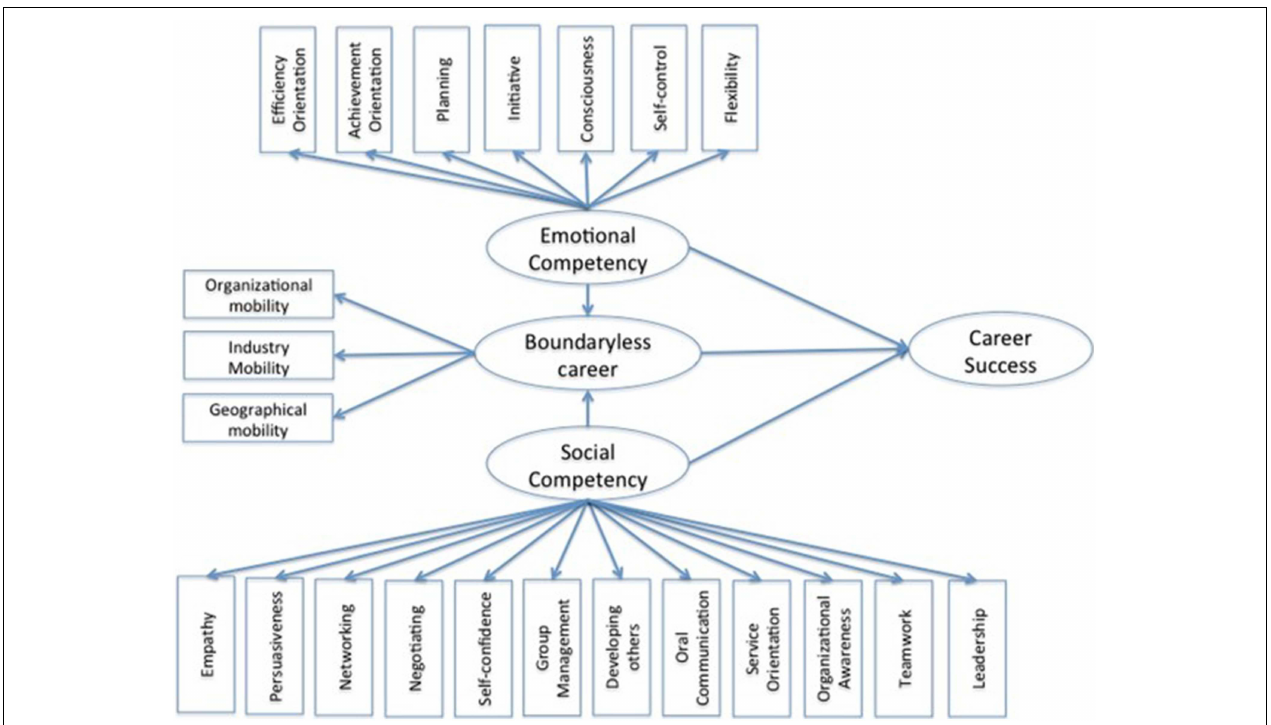
FIGURE 1 | Conceptual